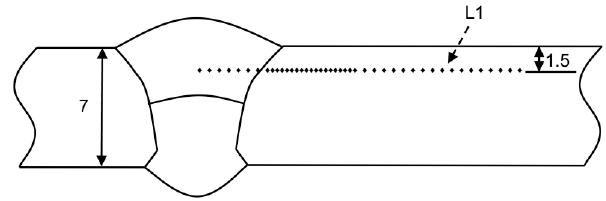
Figure 5. Hardness measurement.